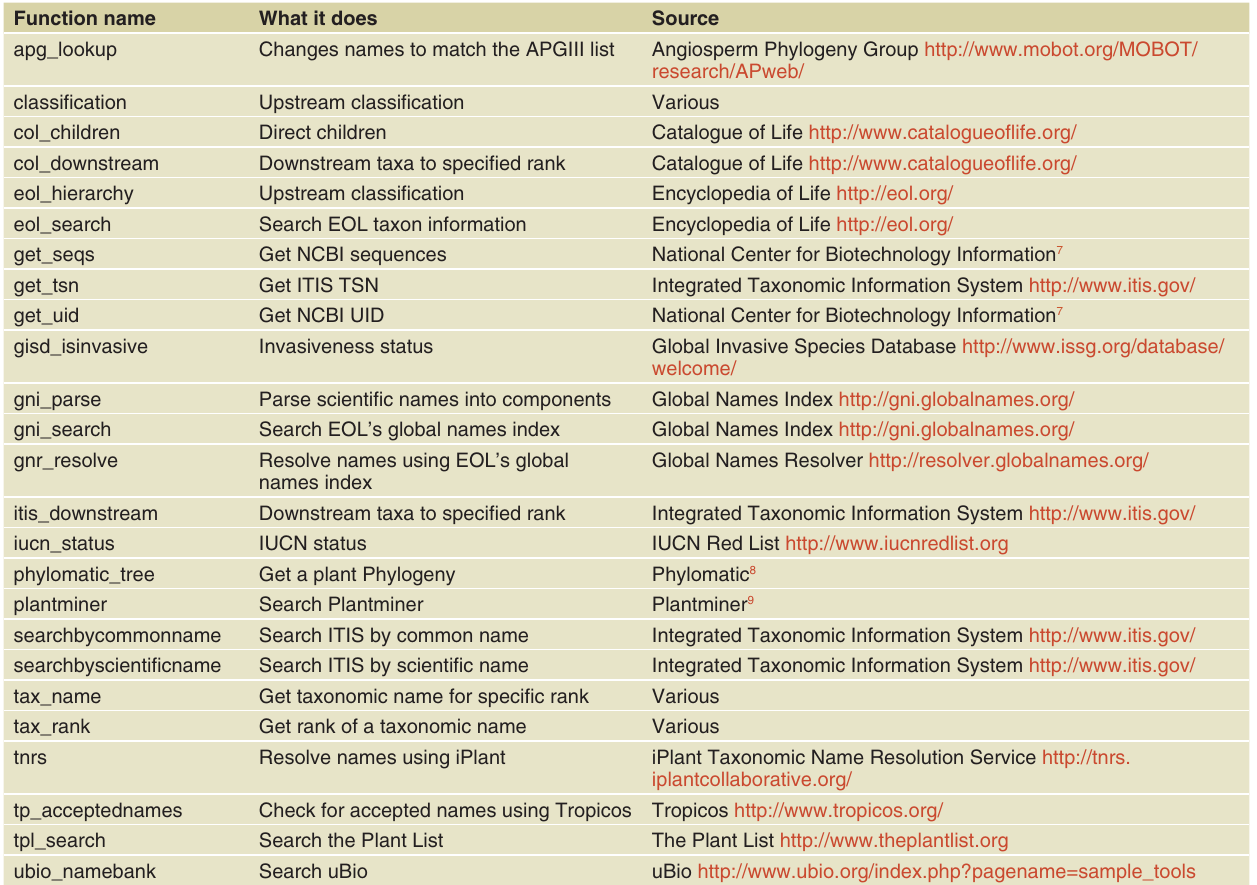
Table 1. Some key functions in taxize, what they do, and their data